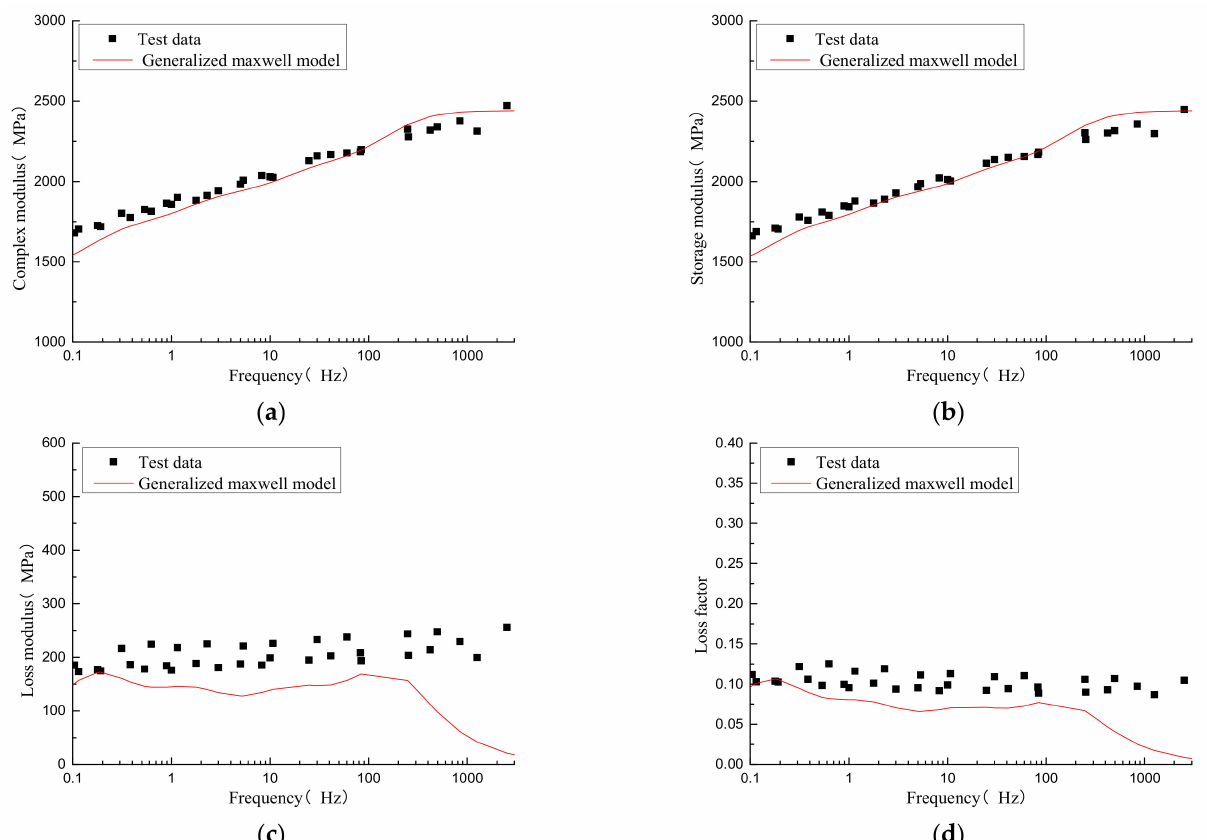
Figure 2. Fitting curves of viscoelastic parameters of composite sleepers at 15 ◦ C: ( a ) complex modulus; ( b ) storage modulus; ( c ) loss modulus; ( d ) loss